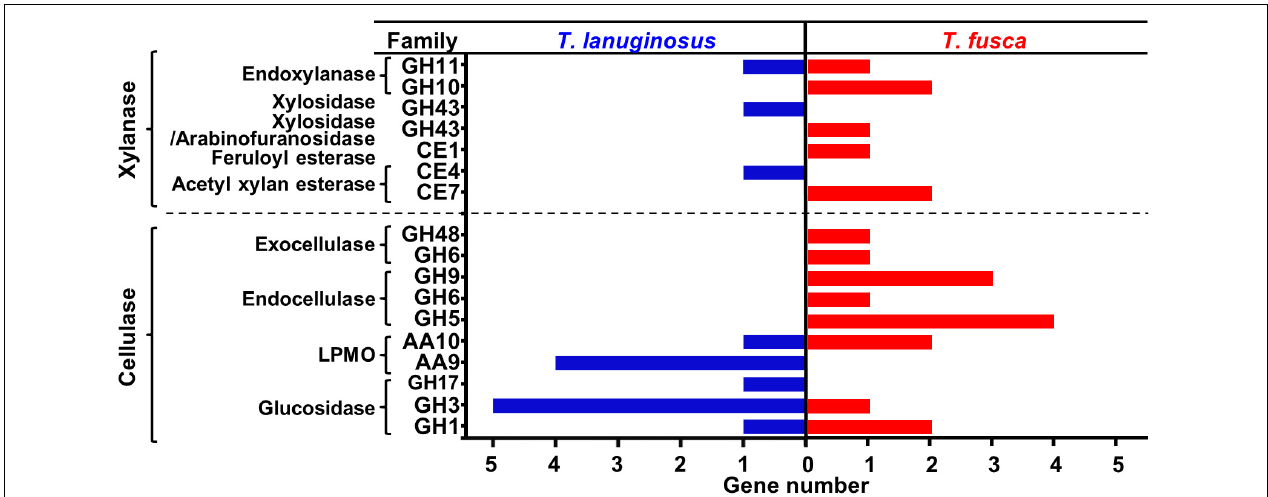
FIGURE 1 | Comparison of lignocellulose-degrading enzyme genes in the genomes of Thermomyces lanuginosus and Thermobifida fusca . The lignocellulose-degrading enzyme genes in the T. lanuginosus and T. fusca genomes were partially complementary.